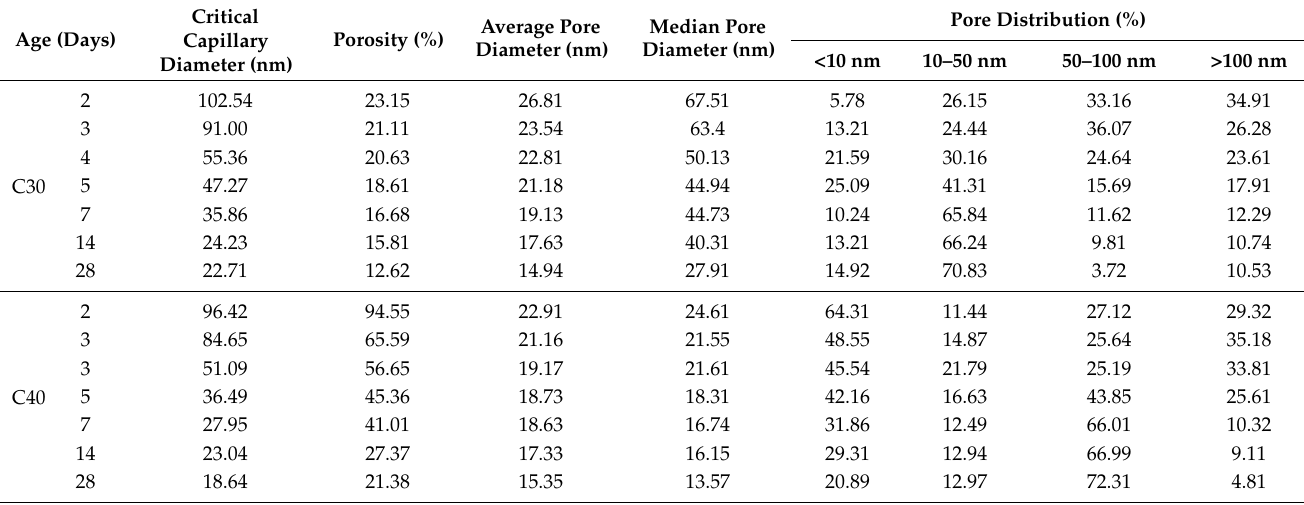
Table 6. Pore characteristic parameters of specimens constrained by steel